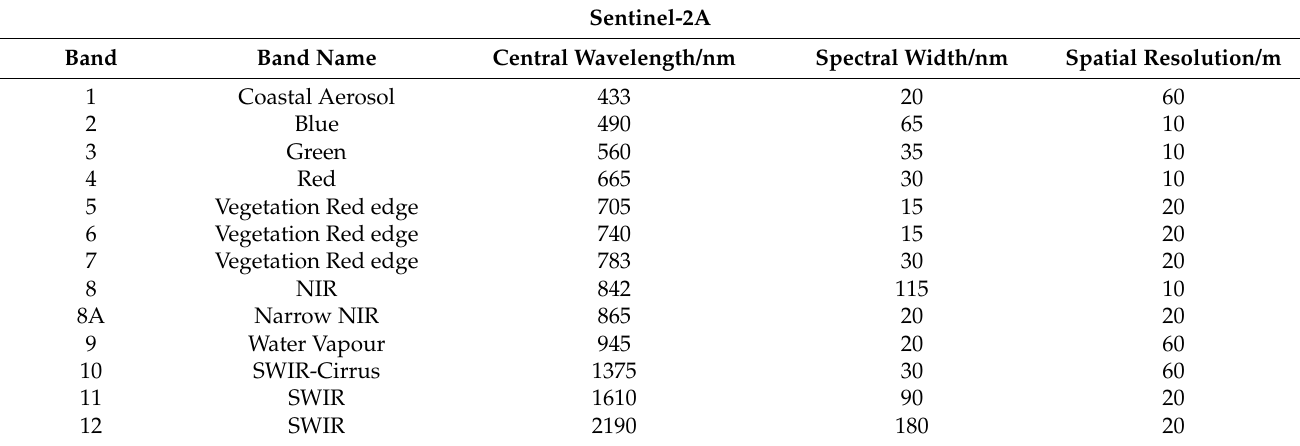
Table 2. The relevant parameters of